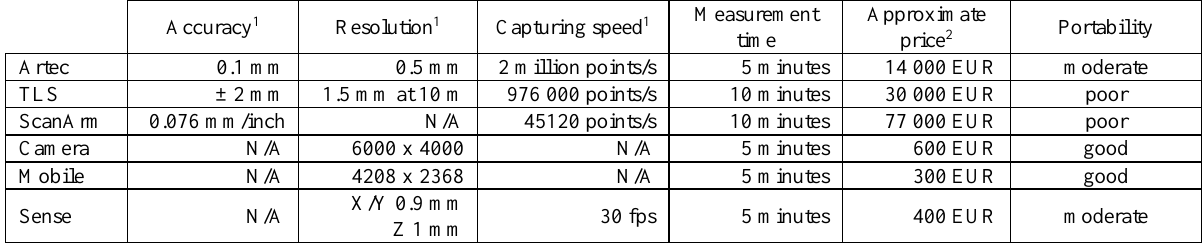
Table 1. Technical specifications of the devices